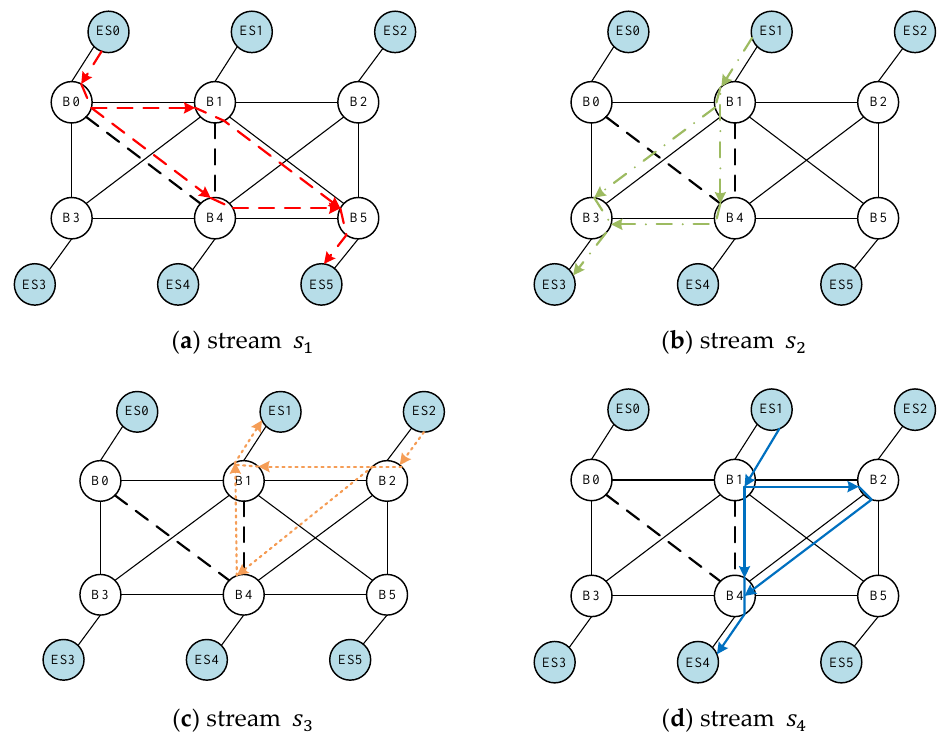
Figure 3. Illustrative example of routing results from shortest multipath routing (SMR).